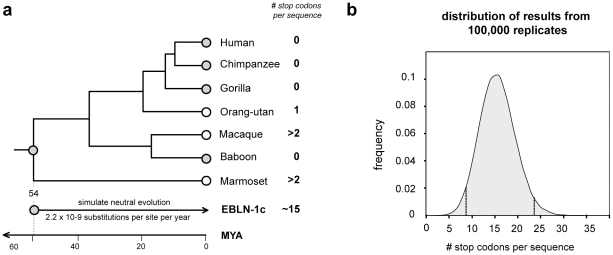
Evolution of EBLN elements in primates.(a) The primate clade marked by an asterisk in the phylogeny shown in Figure 6 is shown in greater detail here, with the number of stop codons in the EBLN-1 locus indicated for seven species. Orthology across these species indicates that EBLN-1 predates the divergence of these species 54 million years ago [42]. Monte Carlo simulations in which a consensus EBLN sequence was allowed to neutrally evolve at the primate neutral rate for this length of time showed that the average number of stop codons expected after this time is fifteen. (b) The distribution of the number of stop codons from 100,000 simulation replicates. Confidence intervals are indicated.